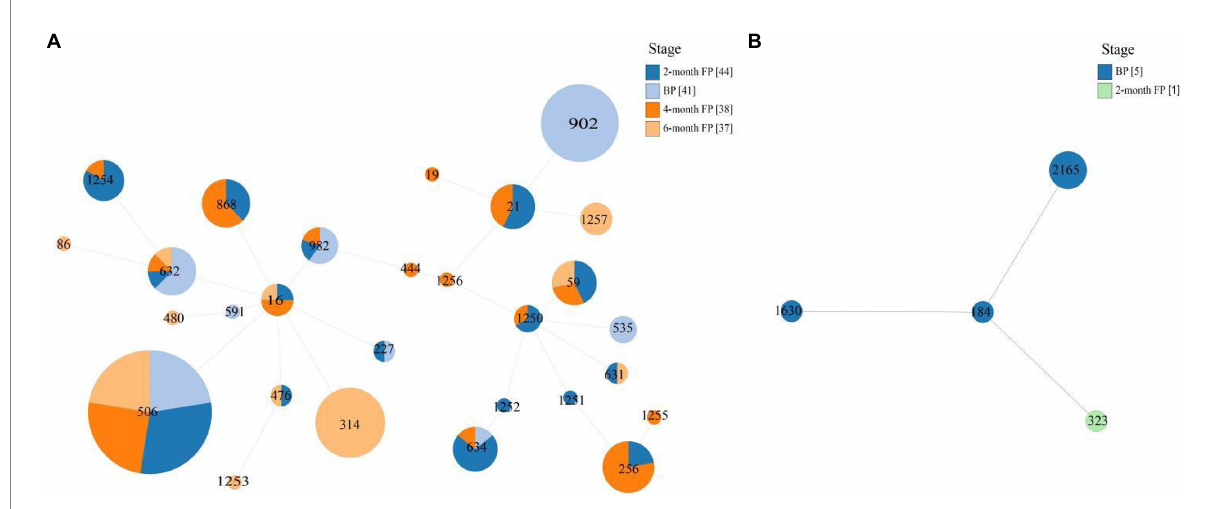
FIGURE 1 Multilocus Sequence Typing ( MLST)-based minimum spanning trees of E. faecalis (A) isolates and E. faecium (B) isolates. The stage is indicated by different